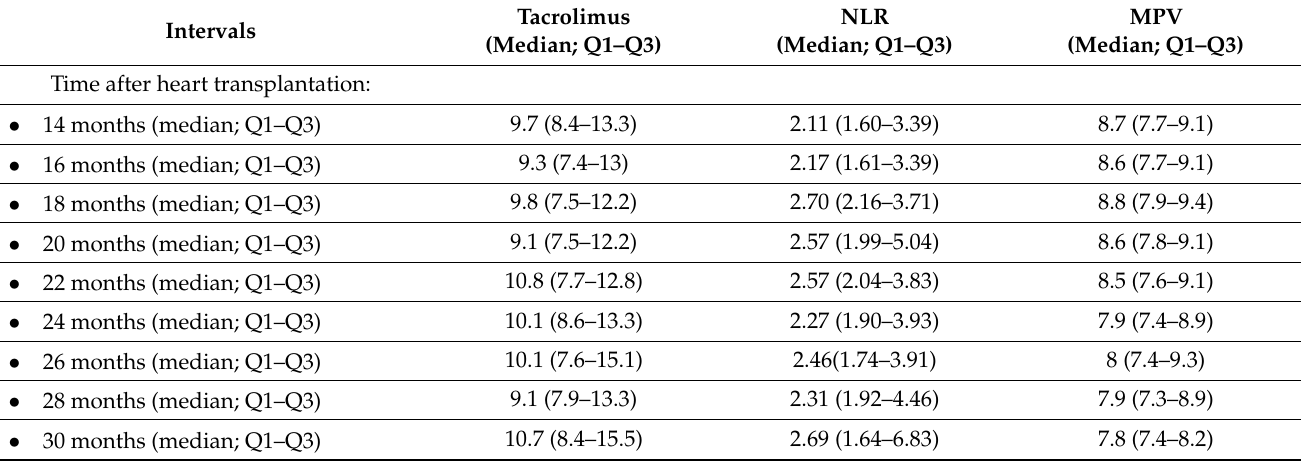
Table 2. Immunosuppressive drug serum levels and NLR and MPV throughout the observation